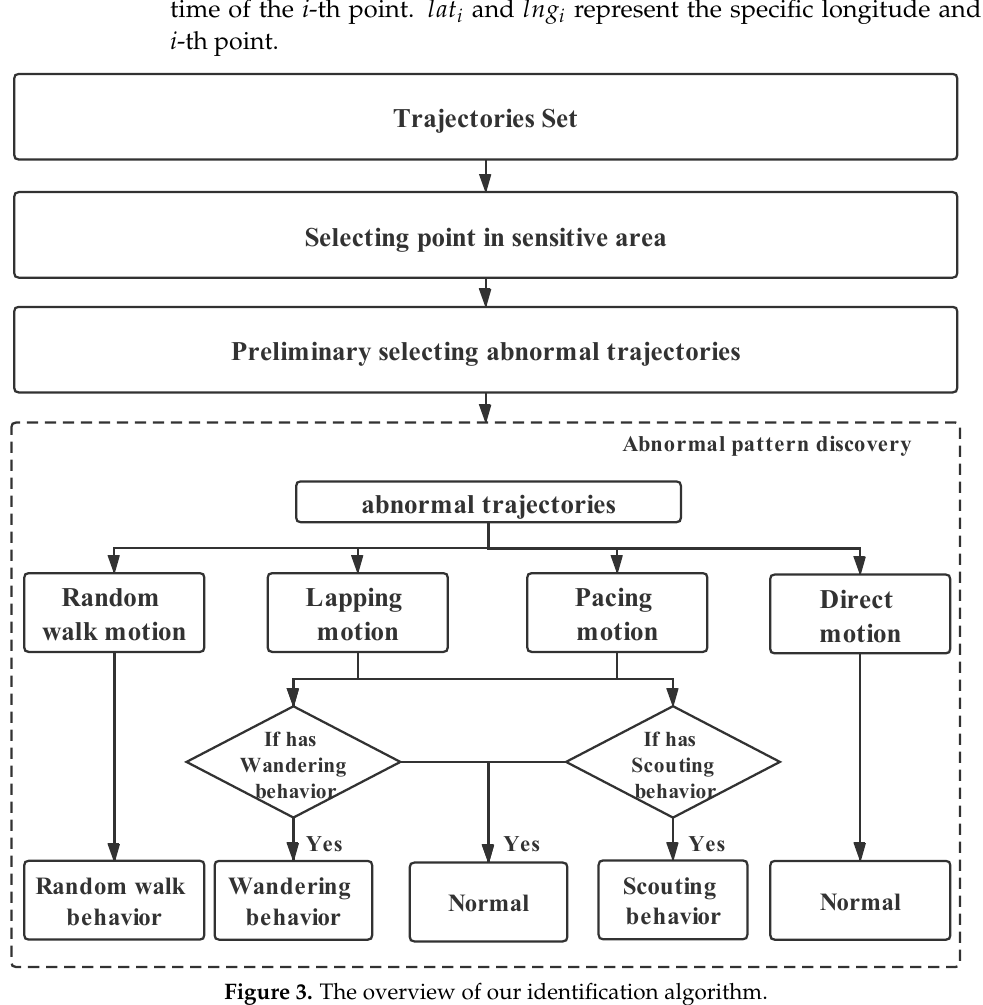
Figure 3. The overview of our identification